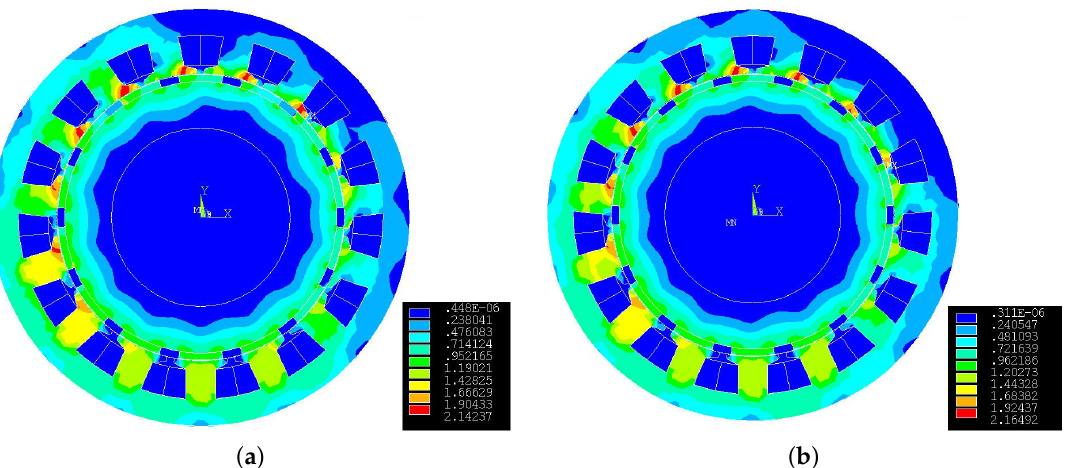
Figure 14. Flux density mappings for a current of 14 A rms corresponding to the coil-rated one. Legend: ( a ) proposed winding arrangement, ( b ) conventional winding